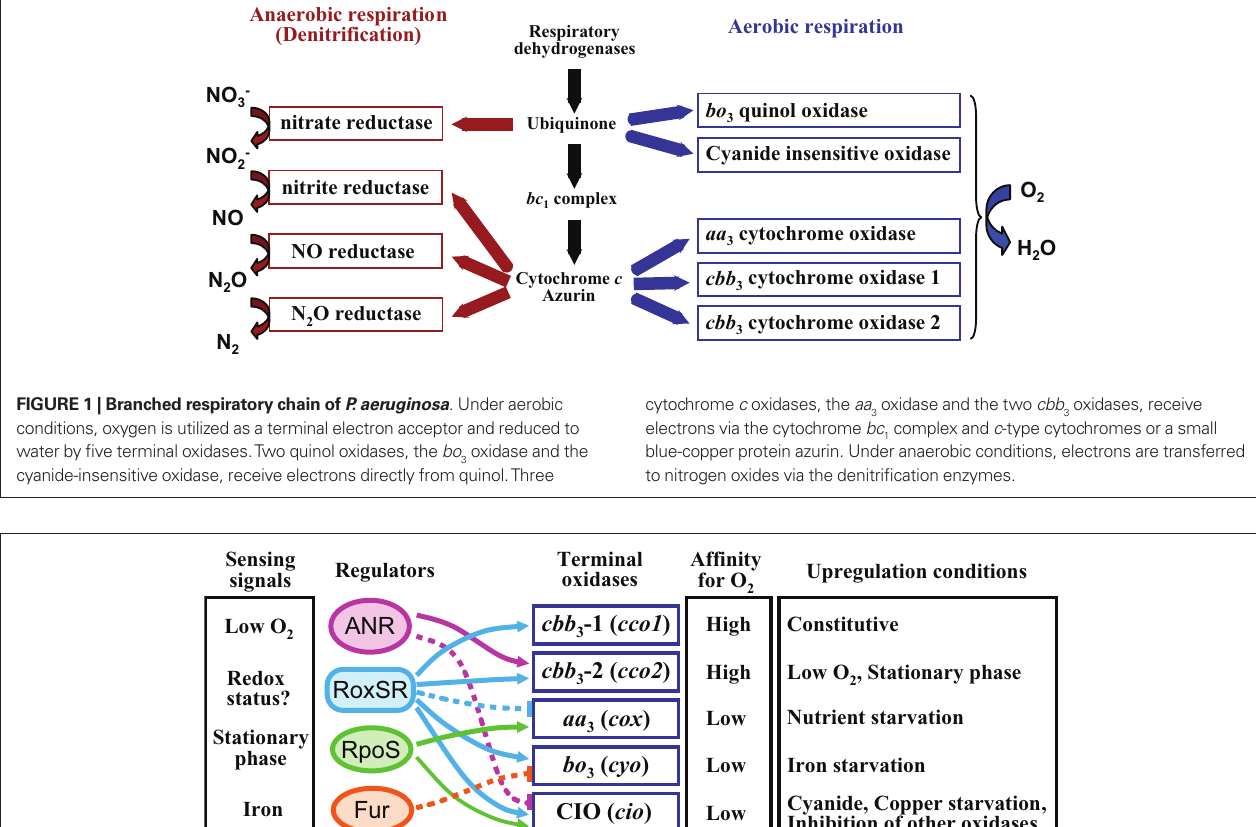
Figure 2 | Schematic model of the regulatory network controlling the multiple terminal oxidases in P. aeruginosa . The sensing signals for the regulators are shown in the left column. Affinity for oxygen and upregulation conditions of the terminal oxidases are shown in the right columns. Activation is indicated by arrows. Inhibition is indicated by bars with dotted